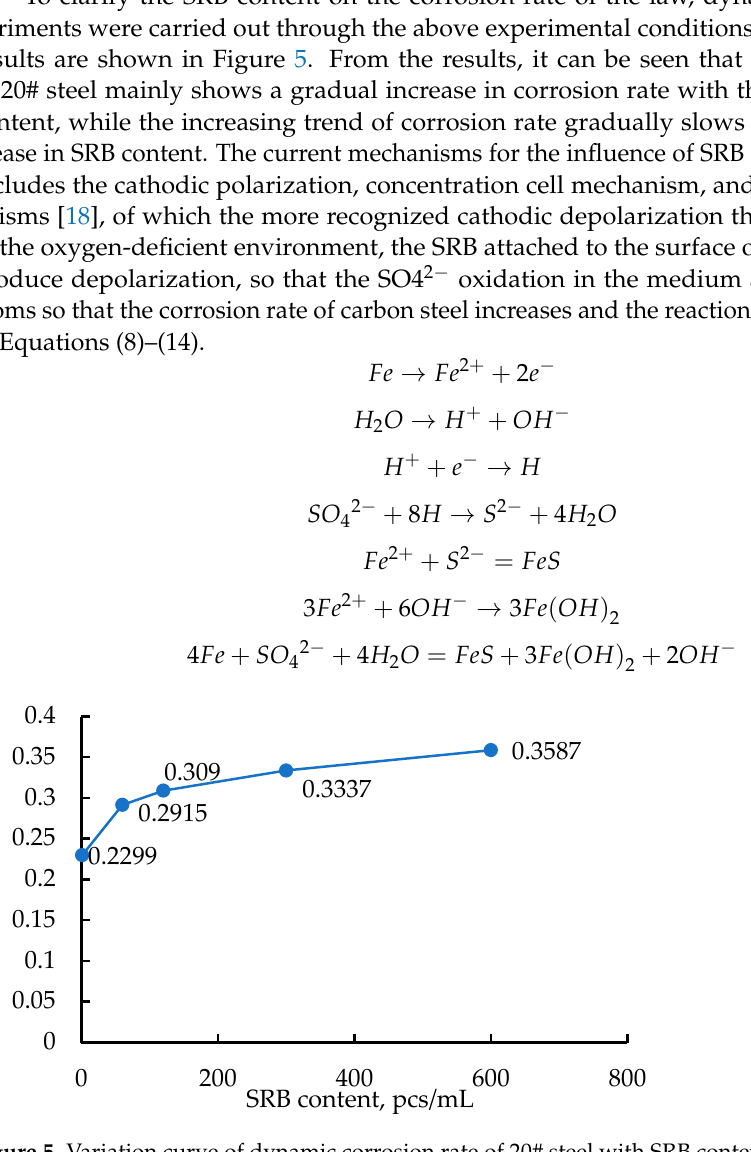
( e ) Figure 6. Microscopic corrosion morphology of hanging piece under different SRB content. ( a ) 0 pcs/mL; ( b ) 60 pcs/mL; ( c ) 120 pcs/mL; ( d ) 300 pcs/mL; ( e ) 600 pcs/mL.